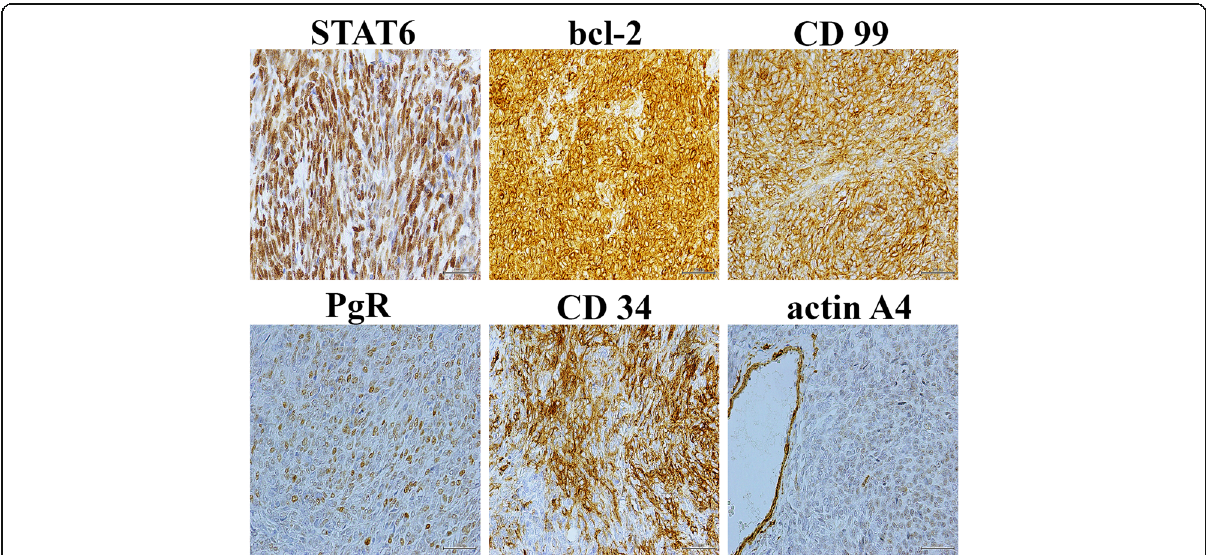
Fig. 3 Immunohistochemical features of the neoplasm. Neoplastic cells are diffusely positive for STAT6, bcl-2, CD99 and CD34; partially positive for PgR and negative for actin A4